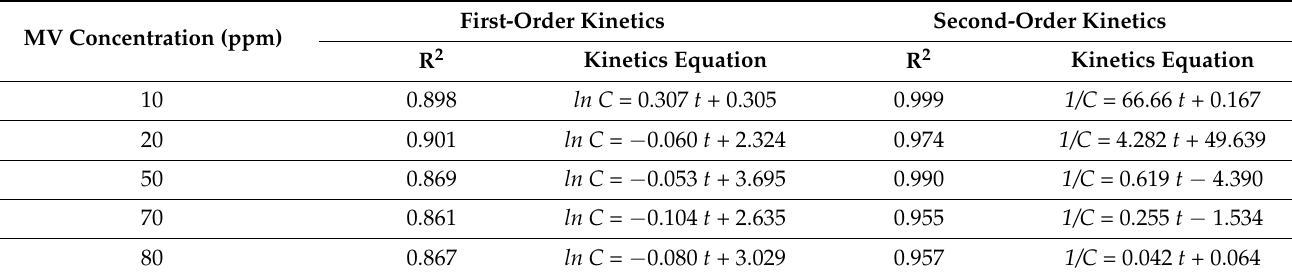
Table 3. Kinetics parameter and equation.